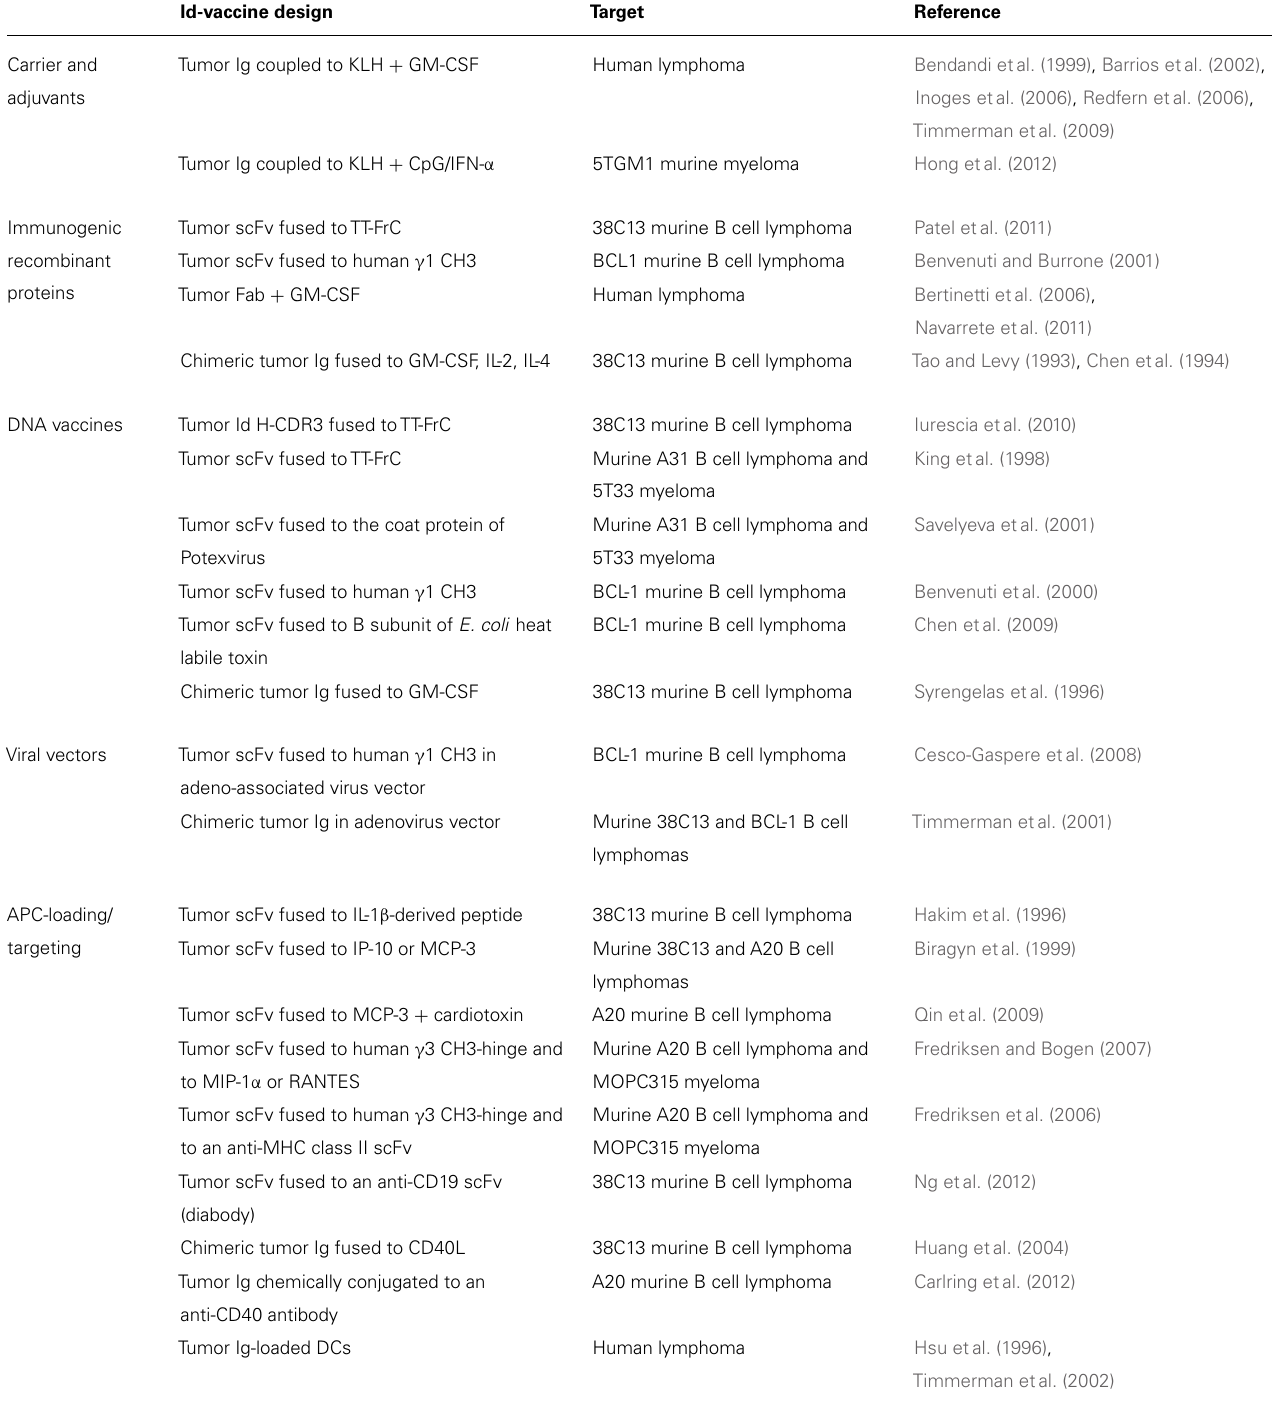
Table 1 | Summary of some vaccine designs to foster anti-Id immune response discussed in the